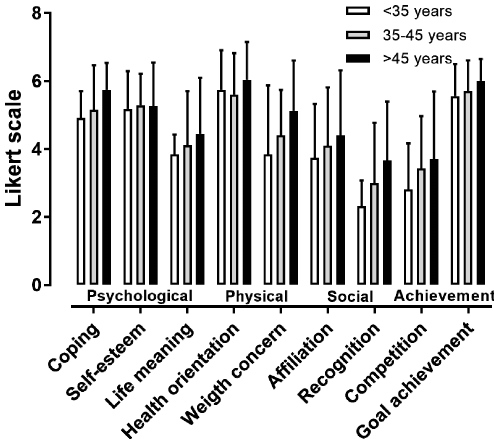
Figure 2. The nine MOMS specific themes by age group in female participants. It should be noted that the Likert scale ranges from 1 to 7.